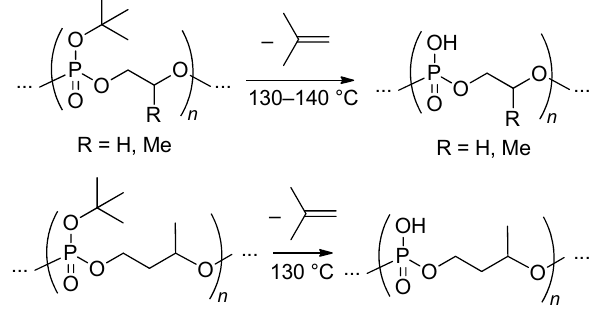
Scheme 17. Formation of PEPA, 1,2-PPPA and poly((1,3-bulylene)phosphoric acid) [71]. To avoid similar cross-linking, Nifant’ev and coll. proposed the use of proton solvents (water, MeOH) for thermolysis of poly( t BuOEP) [86]. Due to the presence of proton solvents, the reactions were completed after 15 min (in H 2 O) or after 1 h (in MeOH) at 80